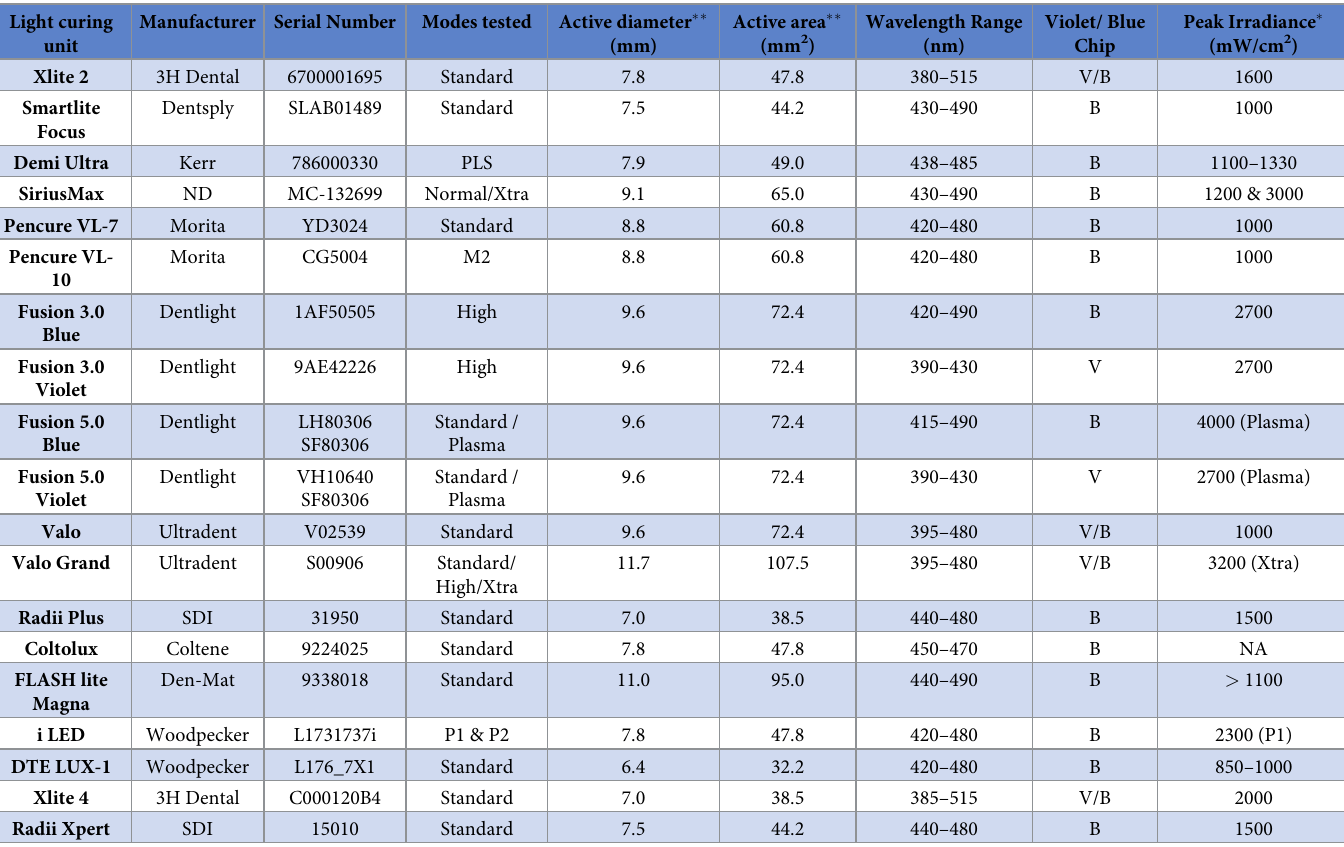
Table 2. Type II LCU optical properties and